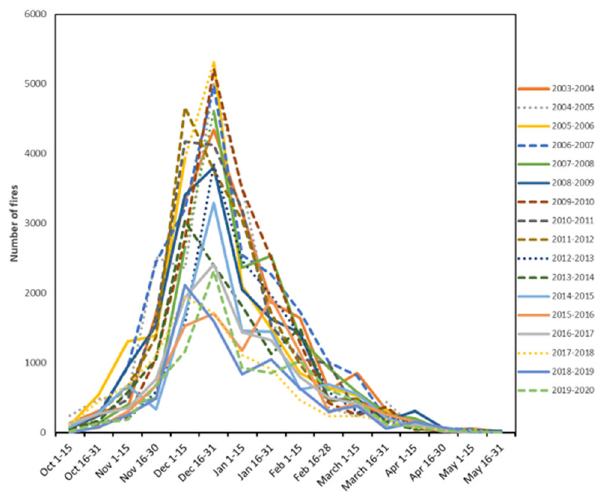
Fig. 1 Number of active fi res for an area of mesic savanna in West Africa covering portions of Mali, Guinea, Burkina Faso, and Ivory Coast with 750 – 1000mm precipitation detected by MODIS over 15 years 9 . Note the high degree of regularity with a large number of fi res lit early (prior to the government ’ s early fi re cut-off of January 1). The recently documented decrease in fi re is also apparent 24